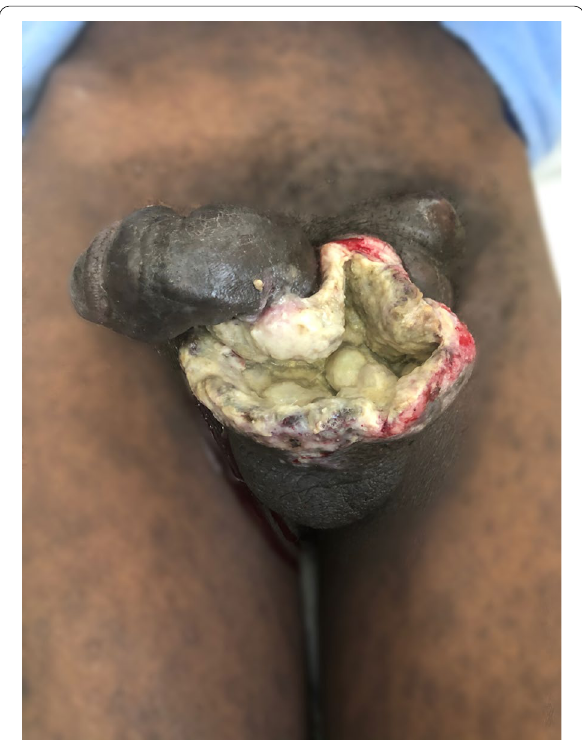
Fig. 1 Pre-operative photograph showing a small, 2 cm superficial ulcer at the base of the left hemiscrotum